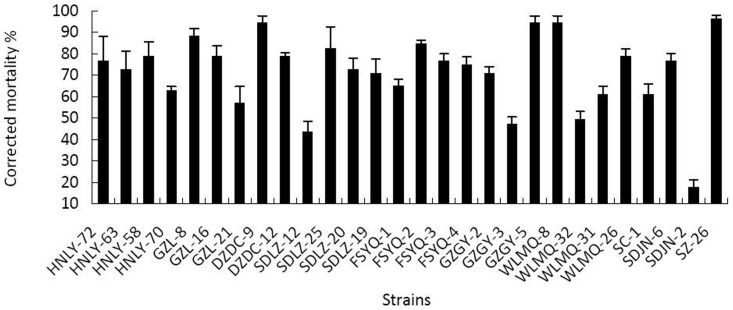
Corrected mortality of 28 isolates against adult T. tabaci 4 days post treatment in the laboratory.Data are expressed as means ± SEM based on 3 replications, each consisting of 20 adults. All strains were tested at 1×107 conidia mL−1.